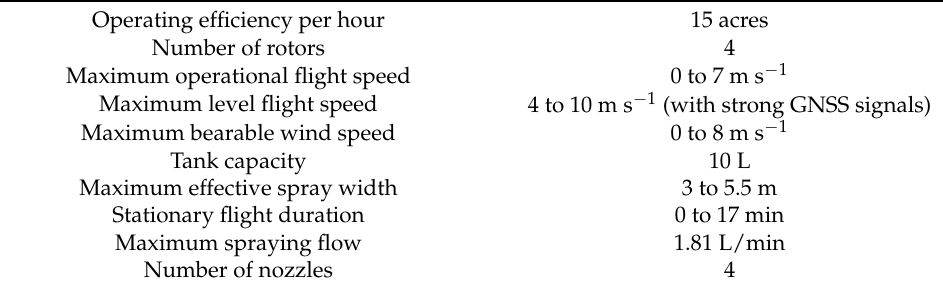
Table 1. DJI T10 UAV